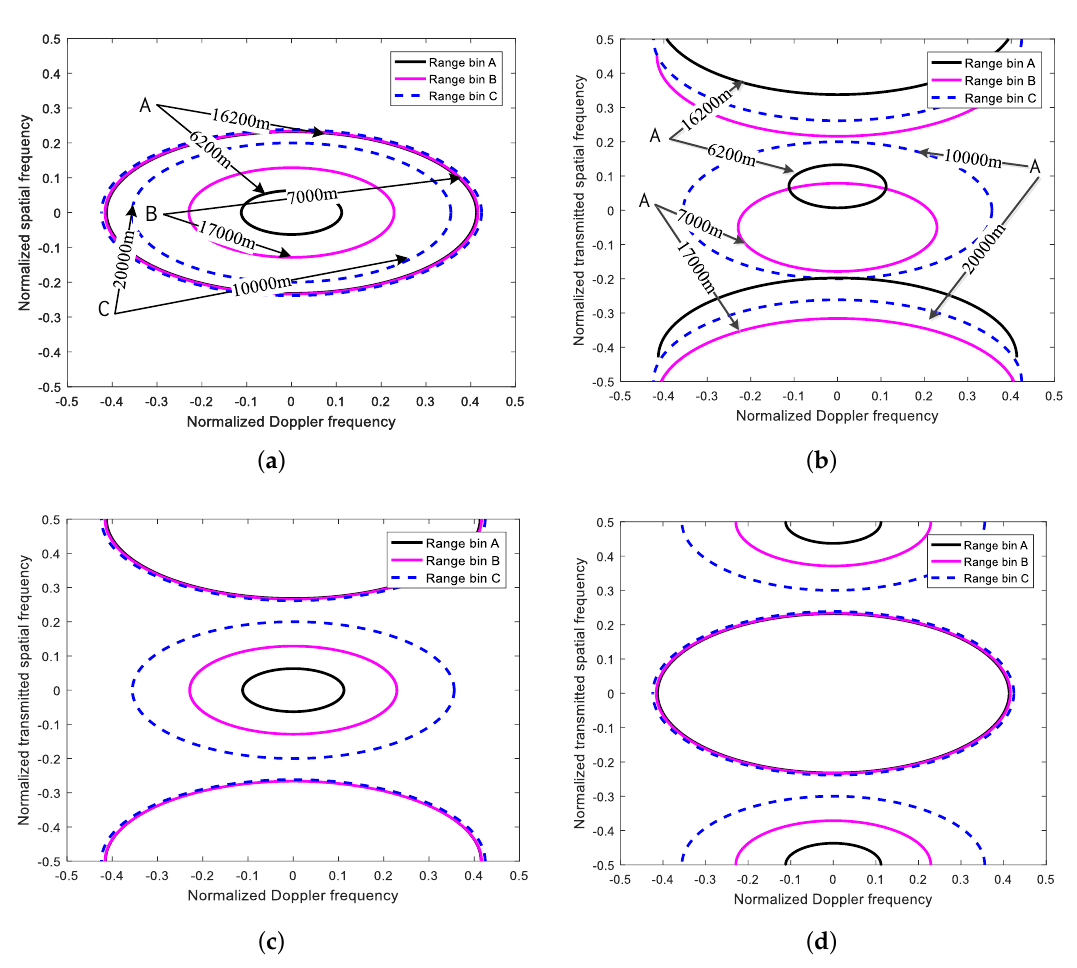
Figure 3. Spatial and Doppler frequencies relationship curves ( a ) Traditional PA radar ( b ) FDA radar before SRDC ( c ) FDA radar after SRDC is implemented when α = 1 ( d ) FDA radar after SRDC is implemented when α =